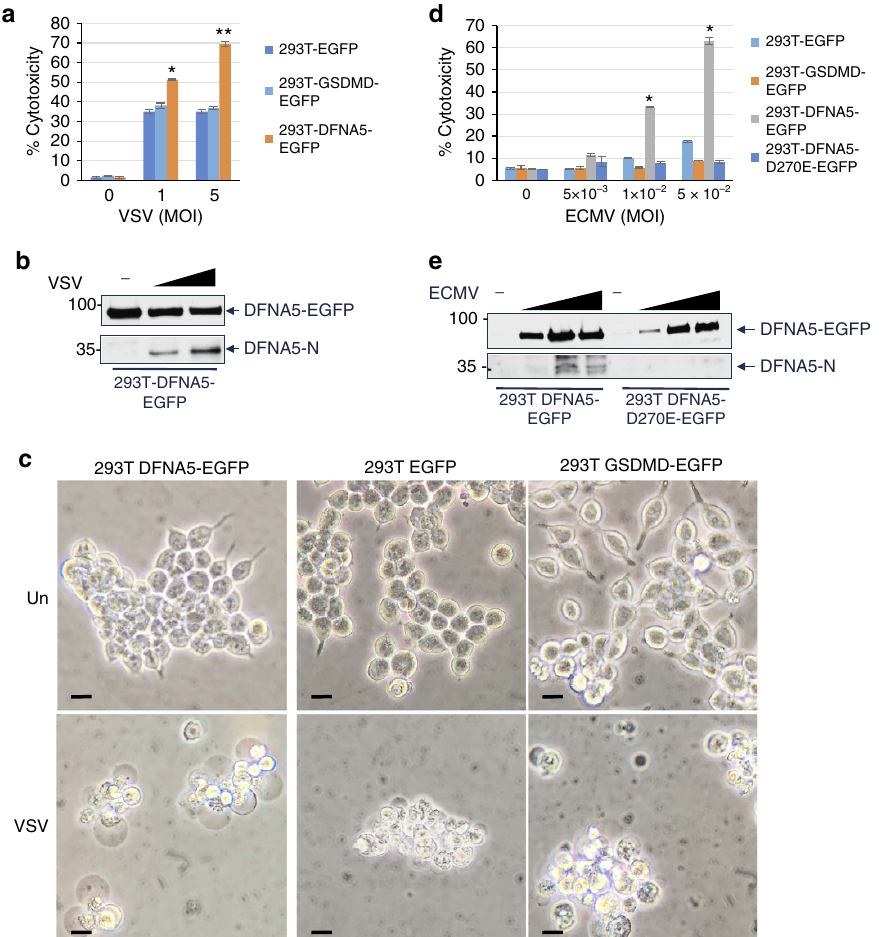
Figure 7 | DFNA5 induces secondary necrosis downstream of viral infection in 293T cells. ( a , d ) Cytotoxicity of VSV ( a ) ( n ¼ 3) (* P o 0.001; ** P o 0.0001, Student’s t -test) or ECMV ( d ) ( n ¼ 3) (* P o 0.0001, Student’s t -test) as measured by LDH release in the culture supernatants of the indicated 293Tcell lines after 18h infection with these viruses. ( b , e ) Immunoblots of DFNA5 in cell lysates from the indicated uninfected ( (cid:2) ), VSV-infected (MOI: 1, 5 for 18h) ( b ) or ECMV-infected (MOI: 0.005, 0.01, 0.05 for 18h) ( e ) 293Tcell lines. ( c ) Microscopic images of the indicated uninfected (Un) or VSV- infected (VSV) 293Tcell lines. Scale bar, 20 m m. Results are representative of at least three independent experiments. Error bars represent standard error of the mean